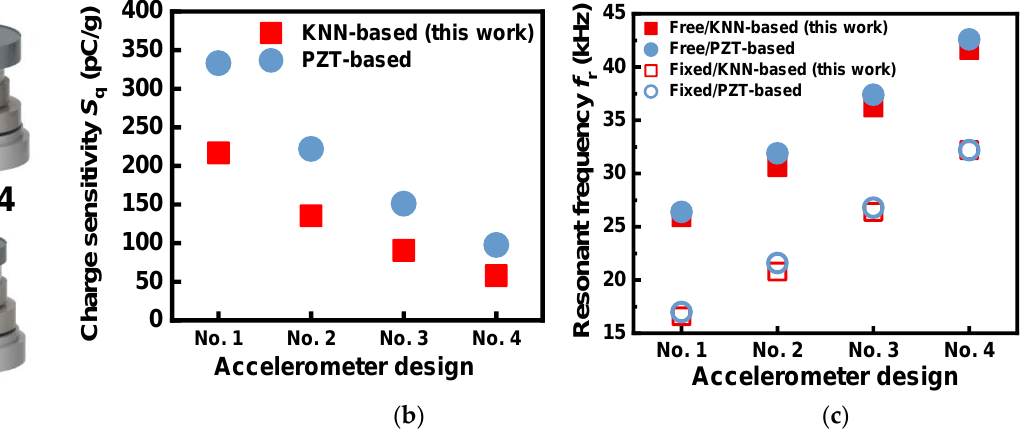
Figure 4. ( a ) Three-dimensional images of the four accelerometer designs (Nos. 1 to 4). ( b ) Numerically calculated results of charge sensitivity S q for the four designs built with KNN-BNKLZ-BS piezoelectric elements. ( c ) Numerically calculated results of resonant frequency f r of the four designs under free and fixed modes. Numerically analyzed results for PZT-based accelerometers [36] are also compared in ( b , c ). Table 2. Values of optimized design variables ( x 1 to x 6 ) for the four accelerometer designs and numeri- cally analyzed charge sensitivity S q and resonant frequency f r for the free and fixed boundary conditions. Design